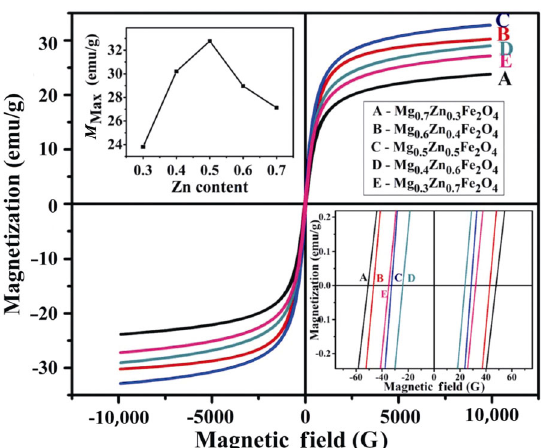
Fig. 5 Magnetization versus magnetic field curves at RT for Mg 1– x Zn x Fe 2 O 4 NPs; the inset at the top shows the variation of M Max with the Zn content and the inset at the bottom shows